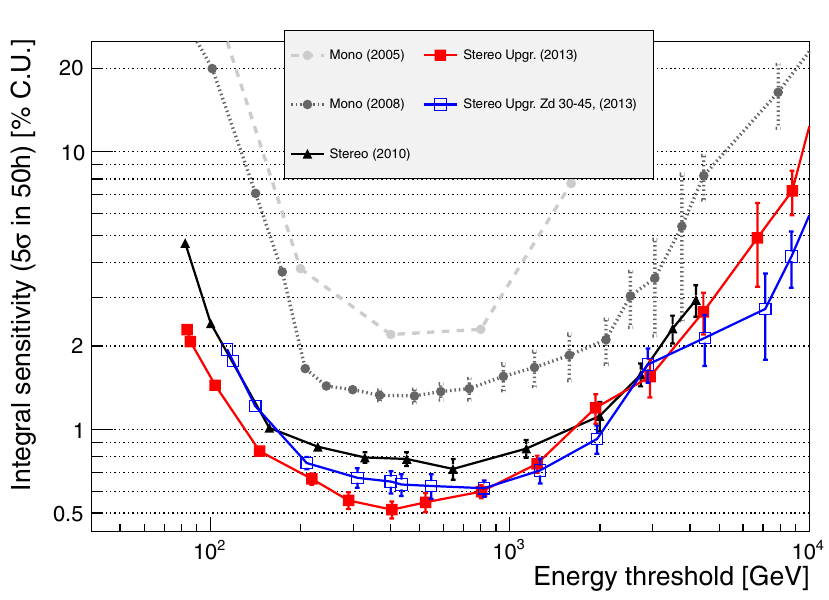
Figure 1. Integral sensitivity of the current MAGIC Stereo system and previous experimental setups, (cid:1) defined as the flux for which N e xcess / N b gd = 5 after 50 h, and calculated using Crab